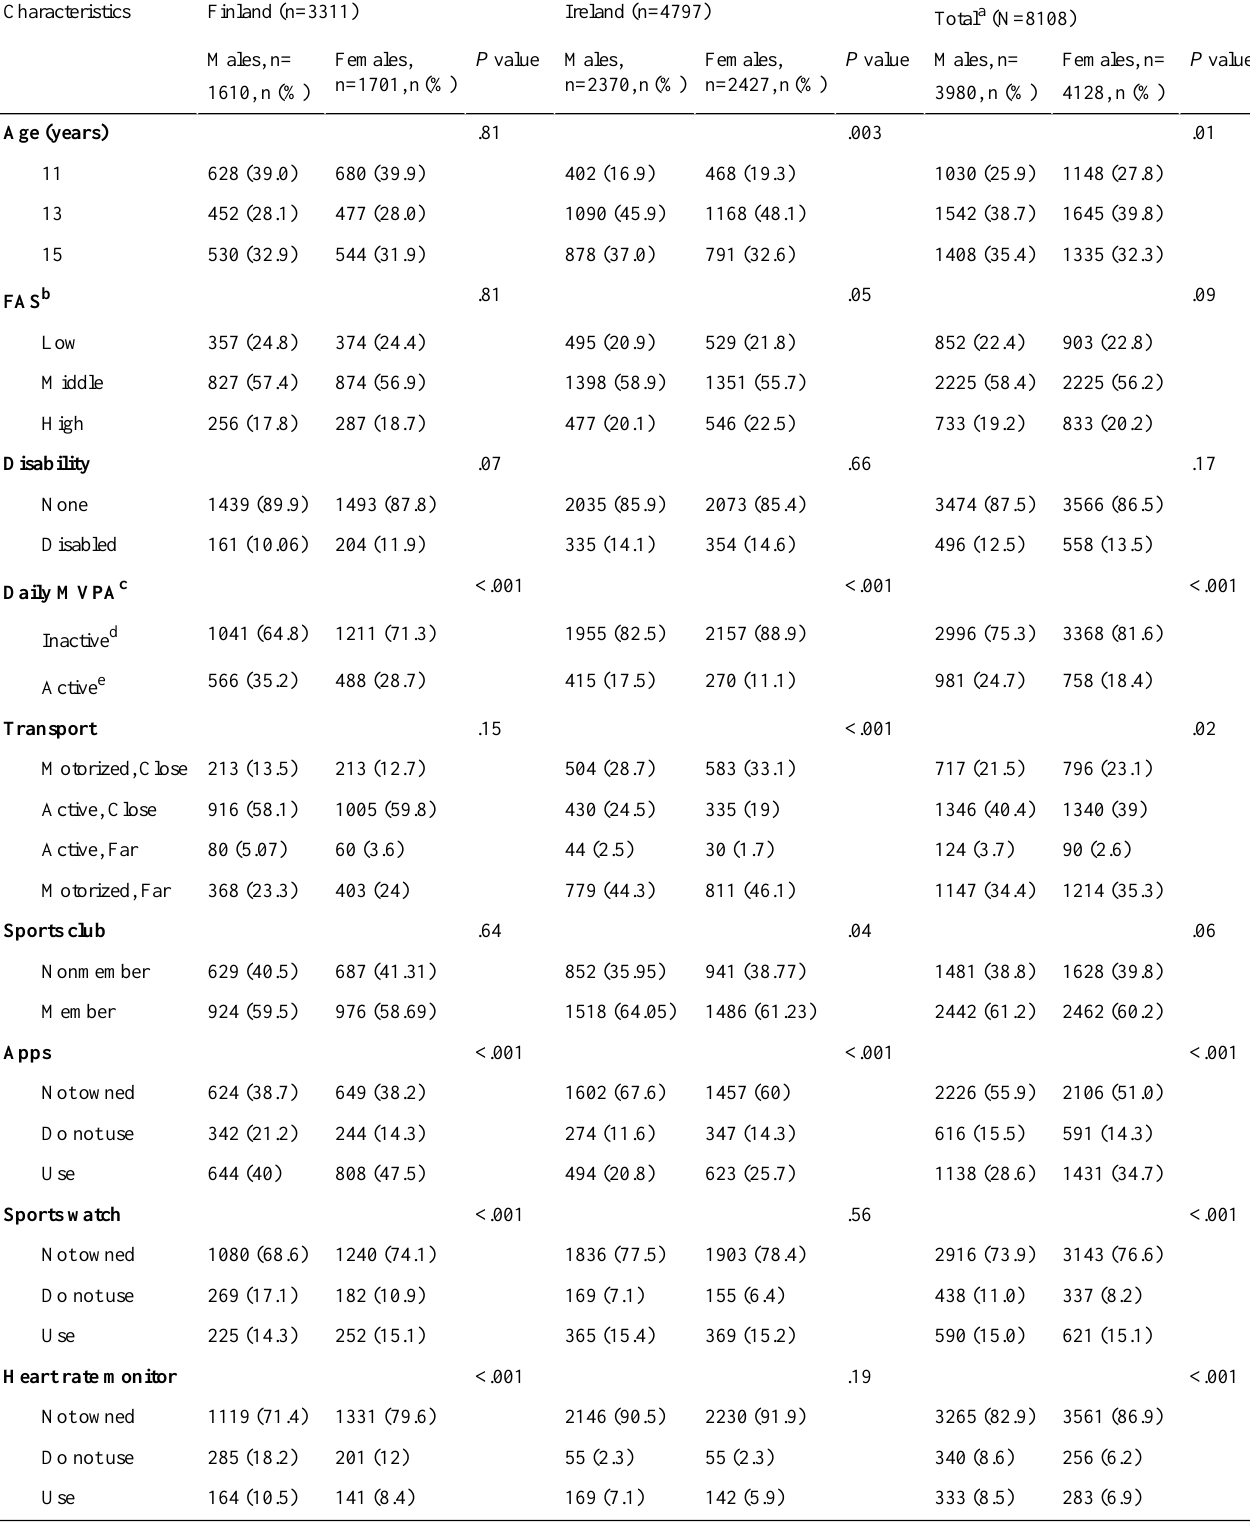
Table 1. Descriptive statistics of the samples by country and